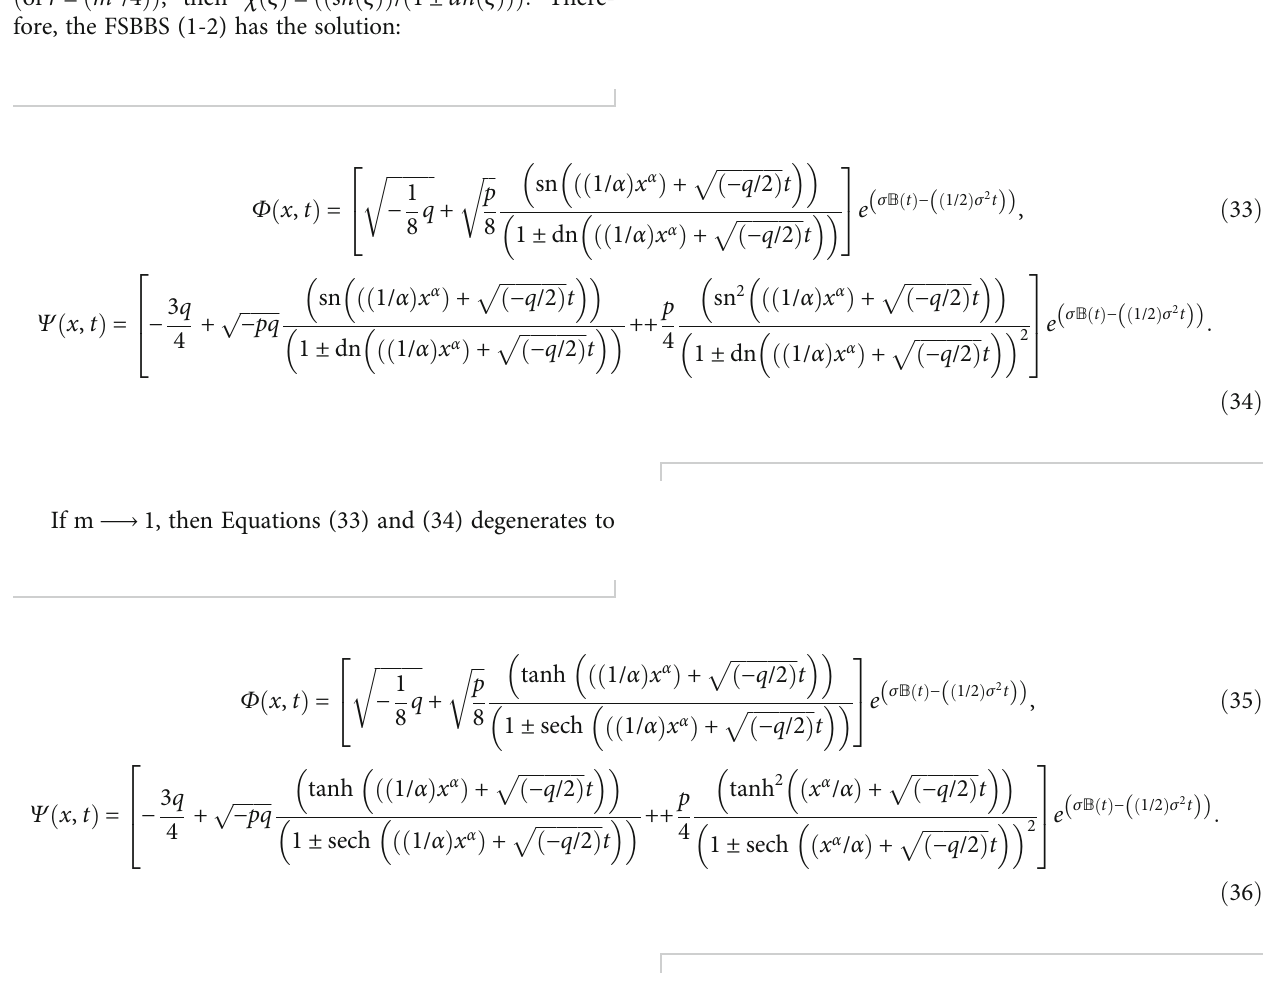
ffiffiffiffiffiffiffiffiffiffiffiffiffi − q /2 ð